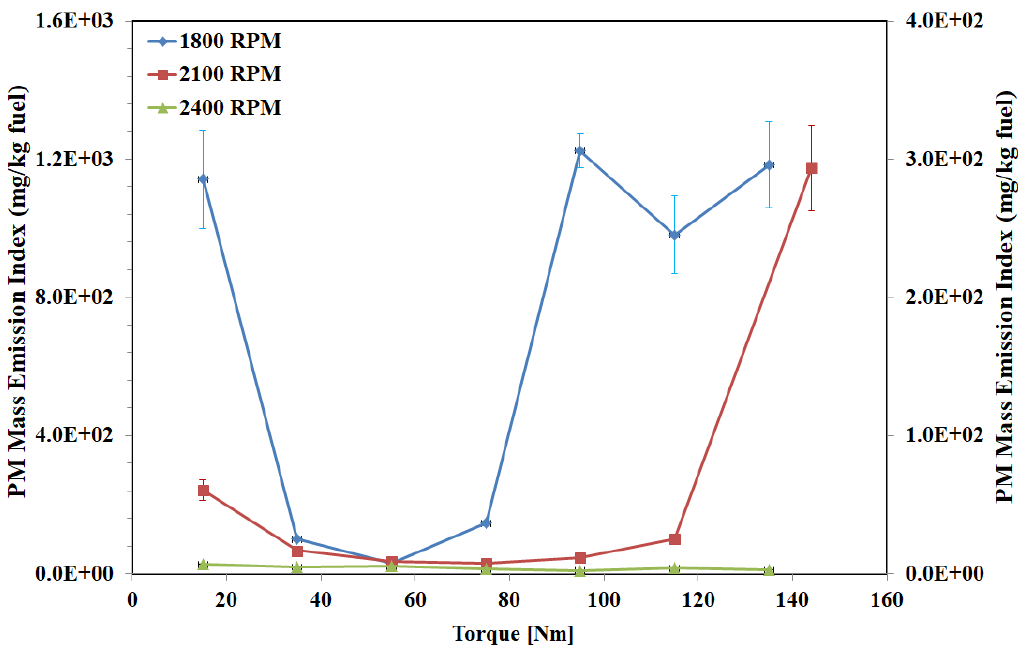
Figure 1. Particle number emissions index (EI N ) versus torque. Error bars represent single standard deviation.